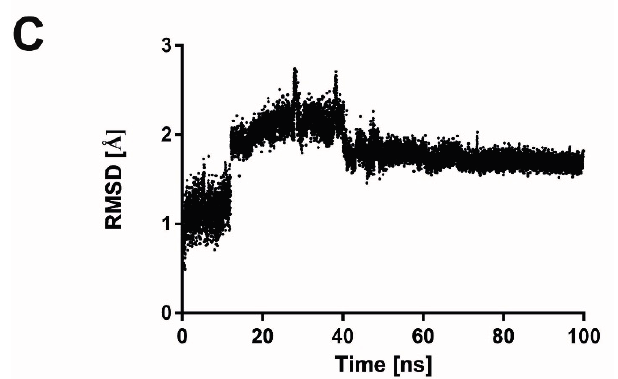
Figure 5. Molecular dynamics simulations results for 4f in complex with P450 14- α -sterol demethylase (homology model) from Candida albicans . ( A ) changes of potential energy for inhibitor-enzyme complex during 100 ns simulations; ( B ) changes in complex RMSD during 100 ns simulations; ( C ) changes in ligand RMSD during 100 ns